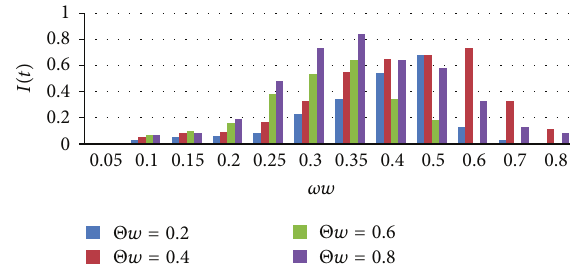
Figure 7: Dissemination probability impact on density of infected